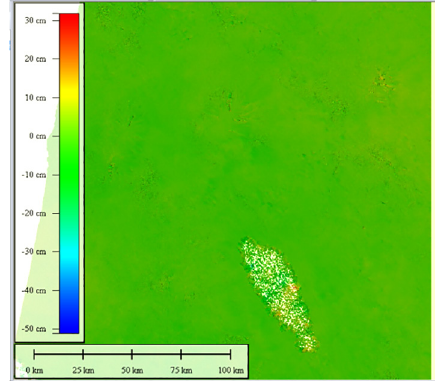
Figure 11. DSM from phase to height conversion